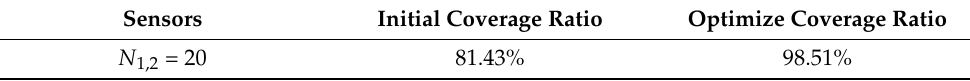
Table 15. Comparison of HWSN coverage optimization experimental results.